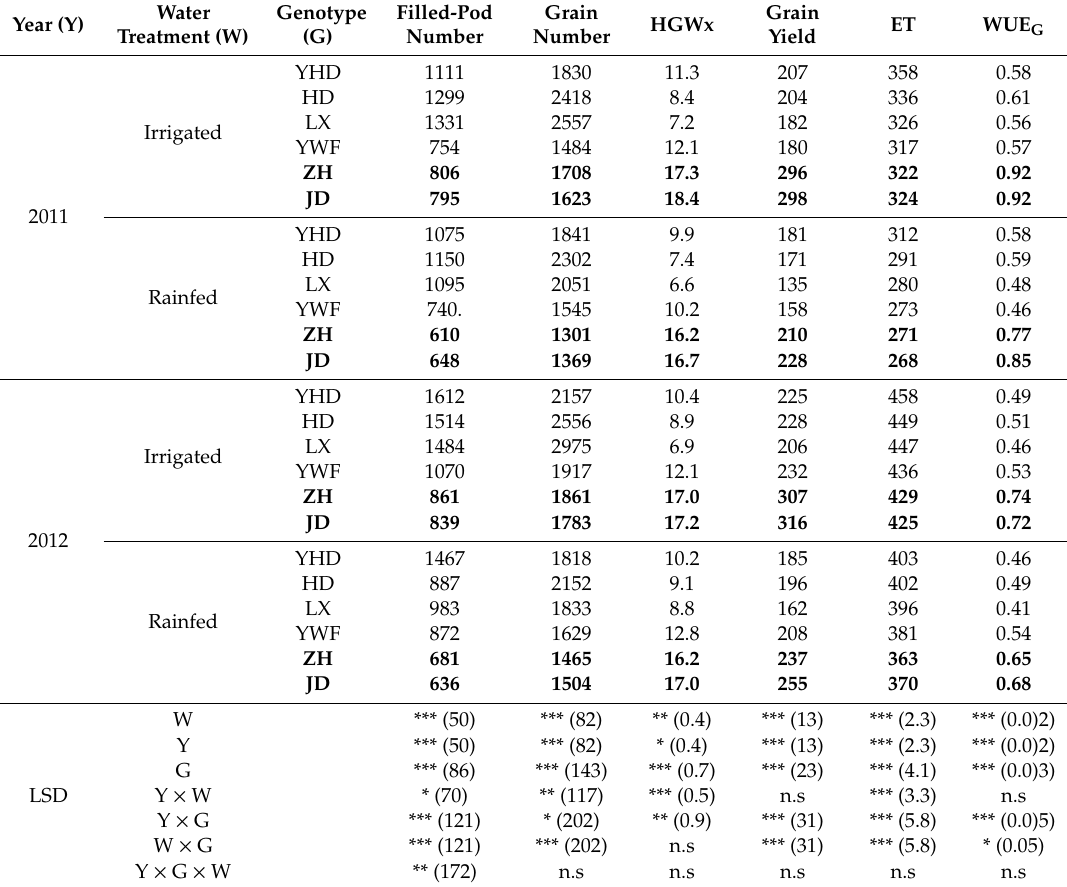
Table 2. Filled-pod number (m − 2 ), grain number (m − 2 ), hundred-grain weight (HGW, g), grain yield (g m − 2 ), seasonal evapotranspiration (ET, mm) and water use e ffi ciency for grain yield (WUE G , g mm − 1 ) for the four landraces (Yuanhuangdou (YHD), Huangsedadou (HD), Longxixiaohuangpi (LX) and Yiwofeng (YWF)) and two recent cultivars (Jindou 19 (JD) and Zhonghuang 30 (ZH) ( bold )) with (i) 40 mm of irrigation at flowering, and (ii) rainfed conditions in the field in 2011 and 2012. The LSD values are given in parenthesis with level of significance: n.s not significant, * p < 0.05, ** p < 0.01, *** p <